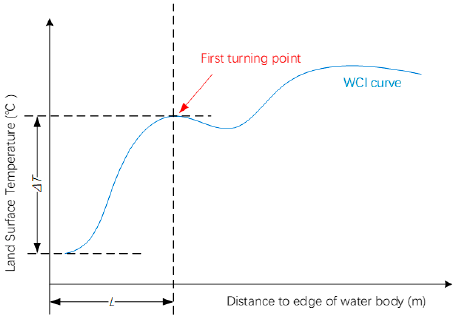
Table 3. Preset constant values of TIRS dataset in Landsat-8 satellite.